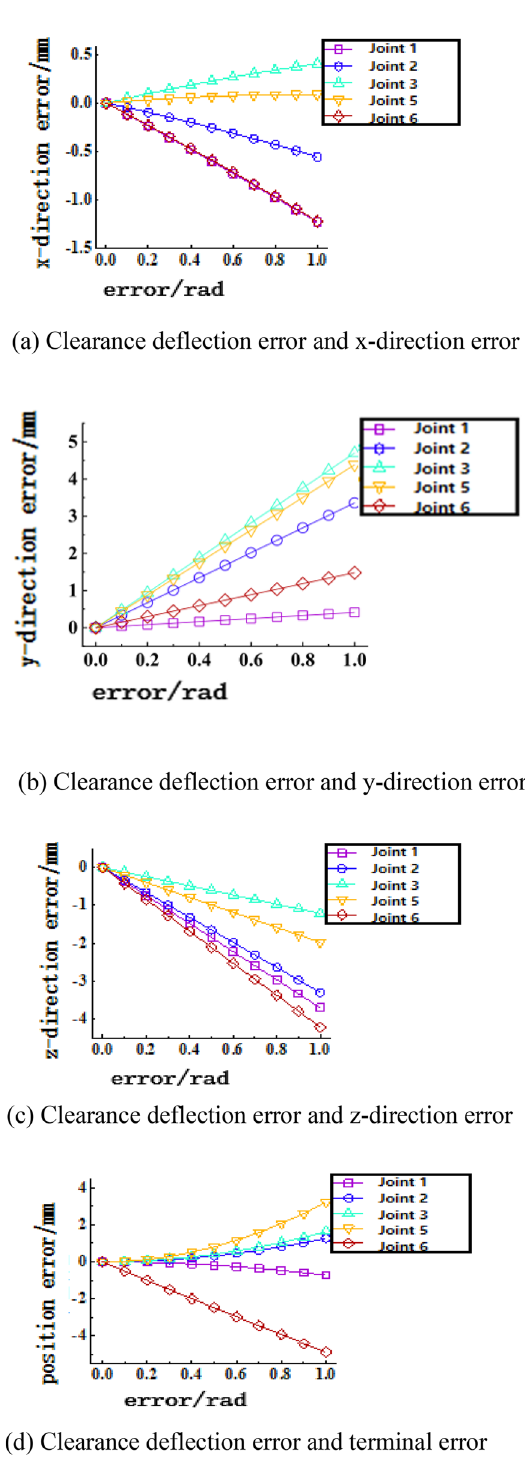
Figure 14. Joint clearance deflection error-terminal position sensitivity curve. ( a ) Clearance deflection error and x-direction error, ( b ) Clearance deflection error and y-direction error, ( c ) Clearance deflection error and z-direction error, ( d ) Clearance deflection error and terminal